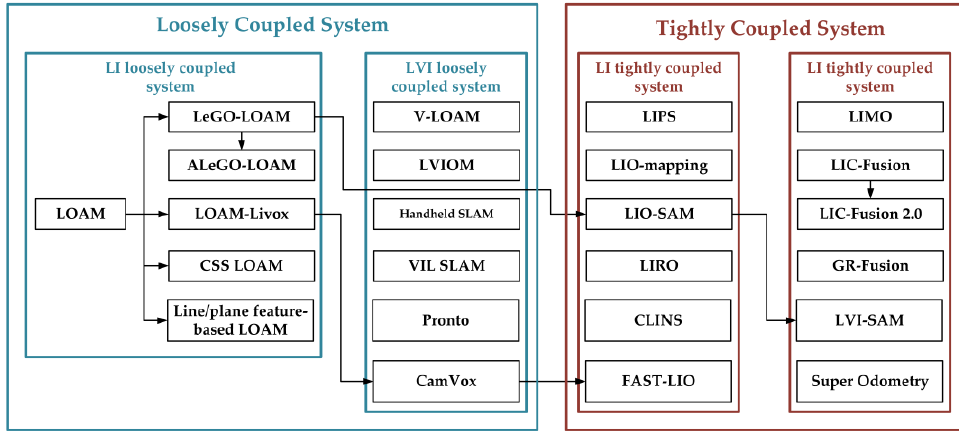
Figure 3. Classification of parts of the work and the relationship between